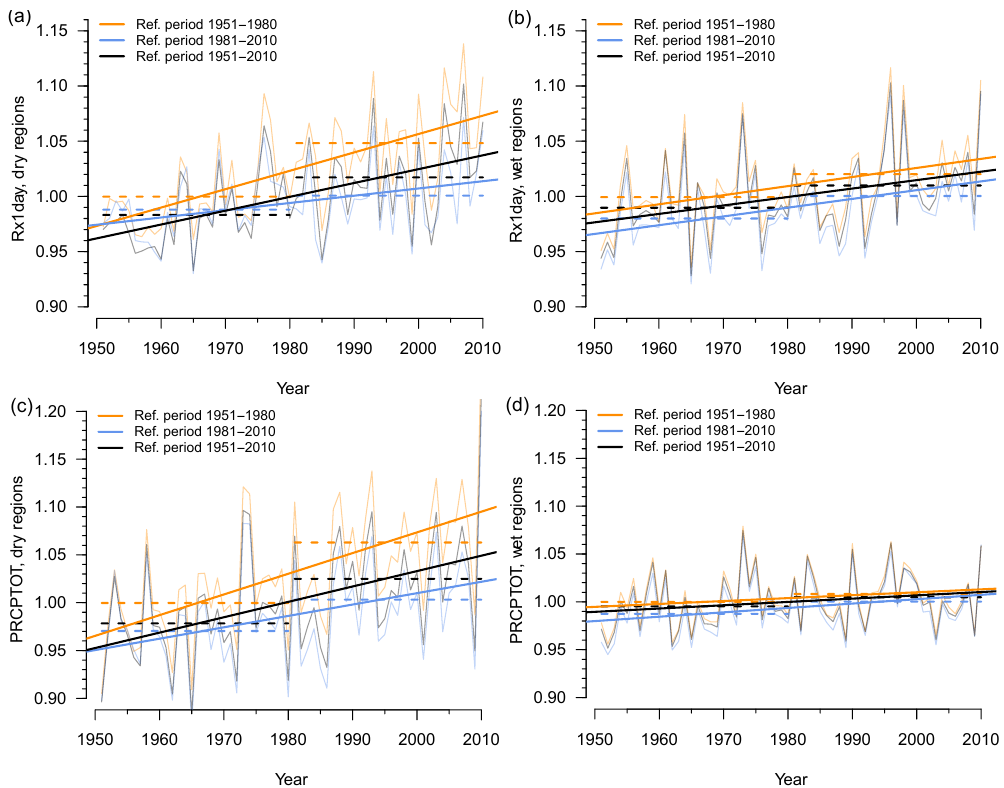
Figure 2. Normalization-induced biases on time series and trend estimates. (a, b) Time series, trends, and 30-year means of spatially aggregated heavy precipitation (Rx1d) in (a) dry and (b) wet regions. (c, d) Time series, trends, and 30-year means of spatially aggregated total precipitation (PRCPTOT) in (a) dry and (b) wet regions. Orange lines are taken from Donat et al. (2016) (ref. period: 1951–1980), black lines are corrected for biases (ref. period: 1951–2010), and blue lines indicate a hypothetical 1981–2010 reference